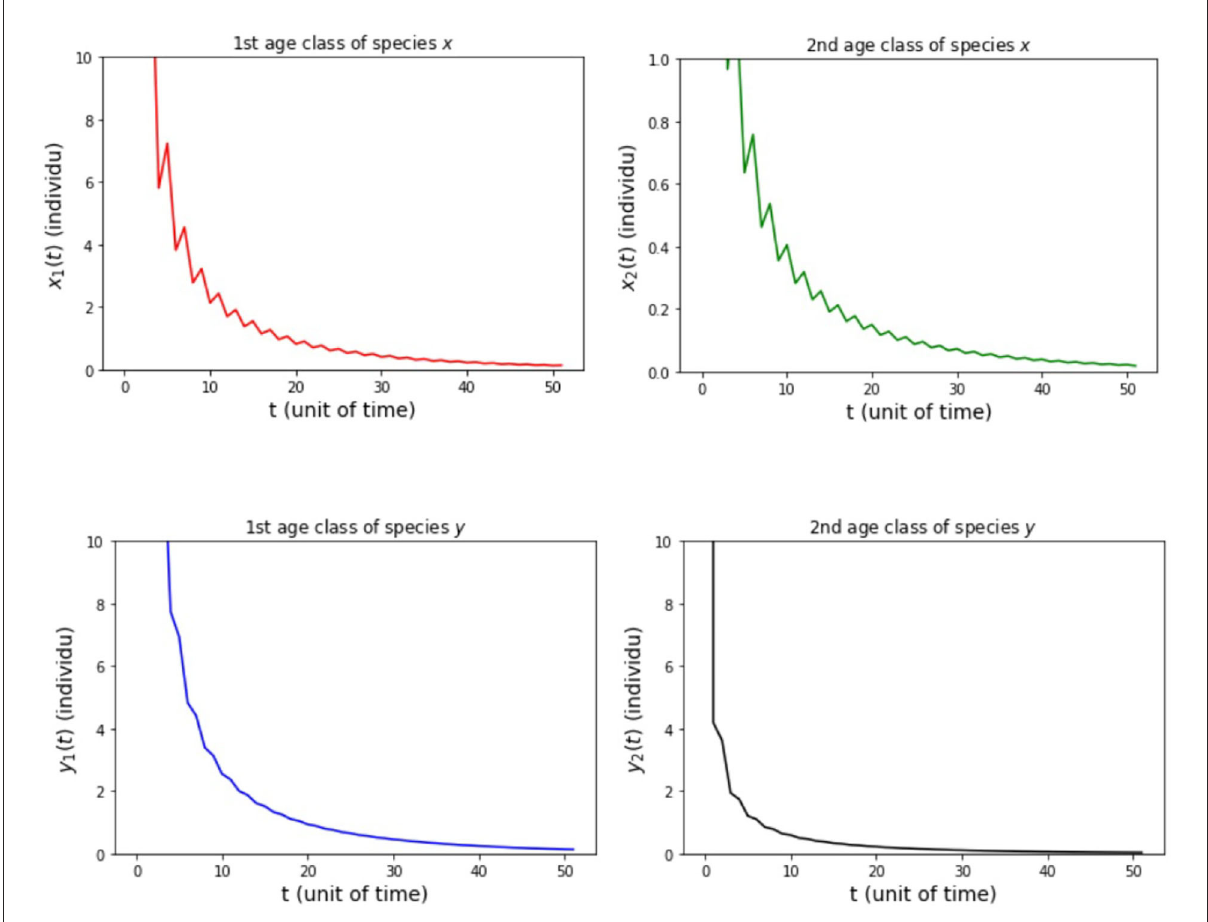
FIGURE5 Population growth of each age class from case (i) Model